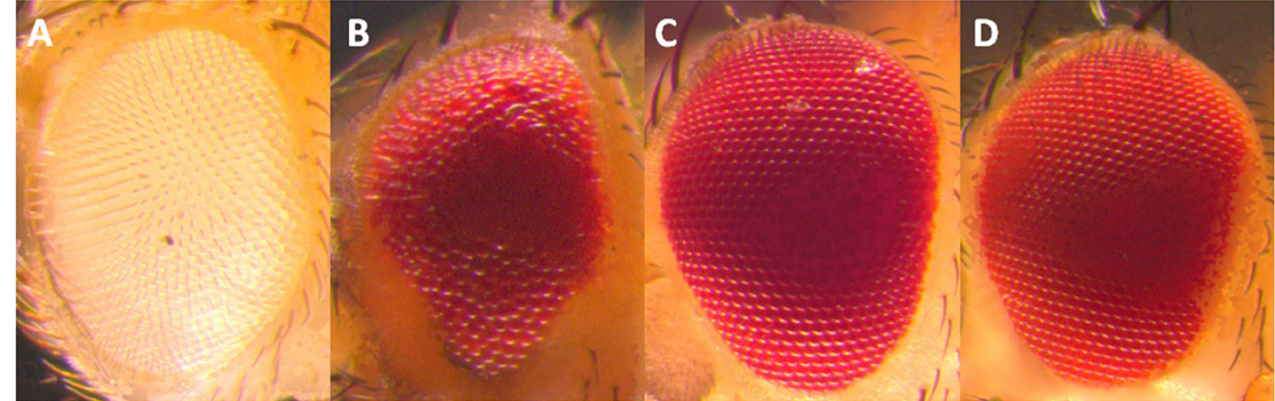
Fig 7. Mutant rescue by targeted expressionof ey and mPax6. (A) eye of y w fly. The ey 2 mutant phenotype (small eye, see Fig B) can be completelyrescuedby targeted expressionof ey (C) and mPax6 (D) drivenby ey-GAL4.